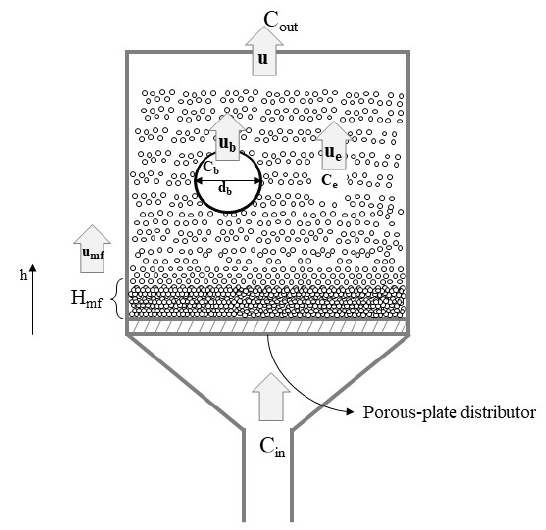
Figure 16. Illustration of a fluidized bed reactor [112]. The minimum fluidization velocity ( u mf ), the bed height at minimum fluidized ve- locity ( H mf ), the bubble diameter ( d b ), bubble growth and bubble velocity were calculated